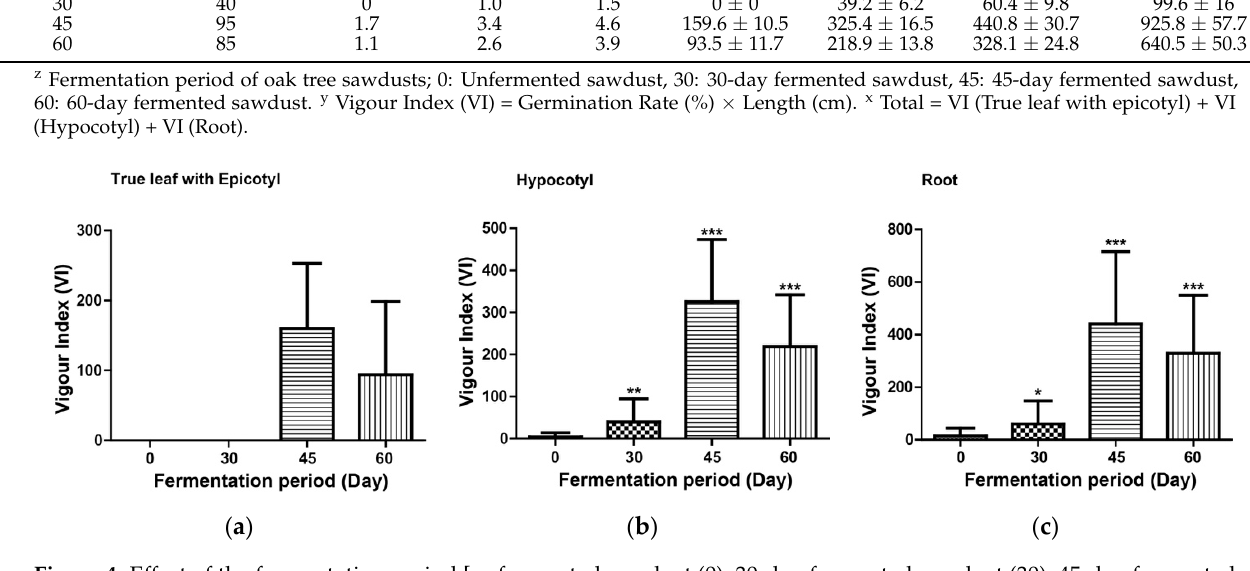
Fermentation Period z